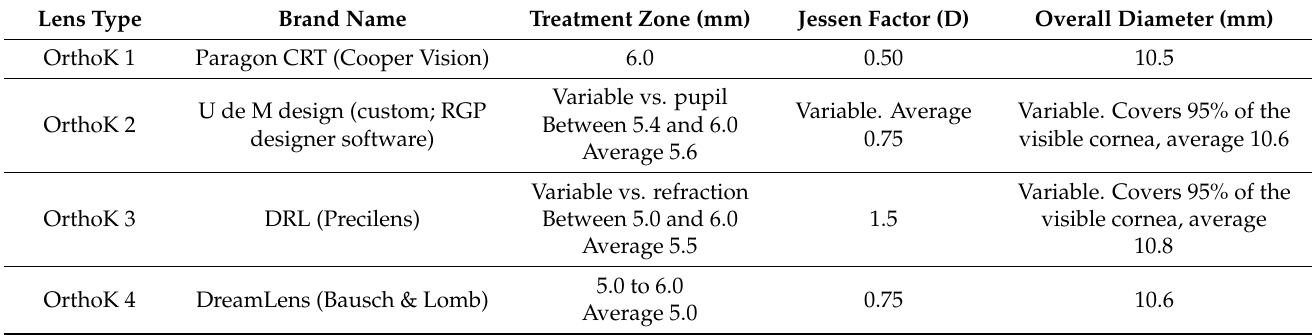
Table 1. Lens variants description,